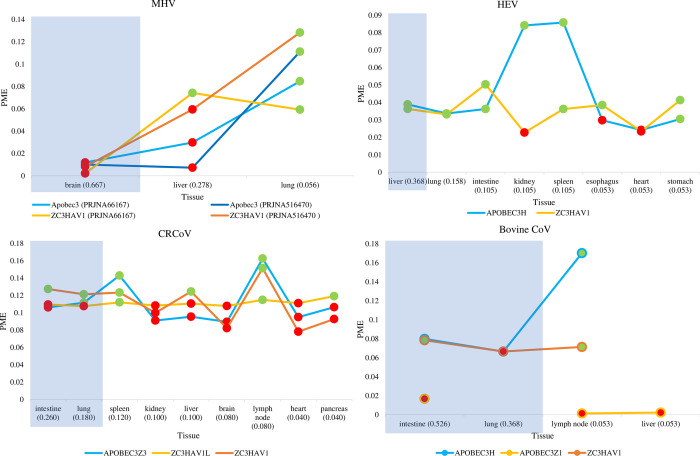
Pig, dog, and cattle tissues that are regularly infected by their respective coronaviruses (HEV, CRCoV, Bovine CoV) have high AVP mRNA expressions, but the mice brain that is regularly infected by MHV does not have high AVP mRNA expressions.The lines show the relative mRNA expressions (PME), for each APOBEC3 and ZAP isoform, among tissues having records of viral infections. Dots highlighted in green and red are PME values that are greater and lower than the averaged PME values, respectively. These PME values were calculated based on averaged mRNA expressions retrieved from the Bovine Genome Database [66], BioProject PRJNA124245 [65], TISSUE 2.0 integrated datasets [64], mouse ENCODE consortium [62] and BioProject PRJNA516470 [63]. For each tissue, the commonness of viral detection (COD) score is appended in brackets next to tissue name. Shaded in light blue-gray are tissues that are regularly infected by the virus (based on highest COD scores).